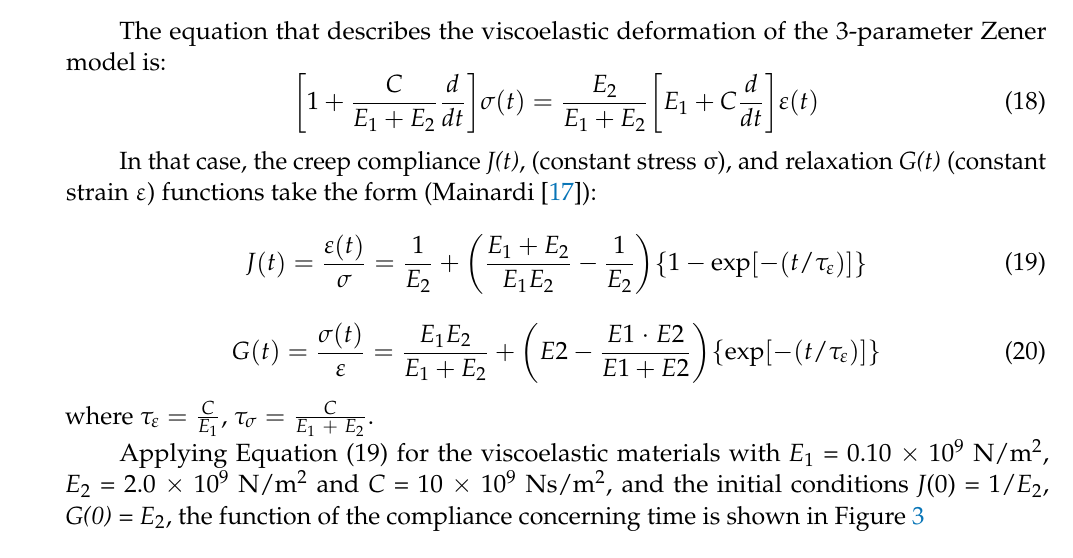
Figure 2. The Zener model.